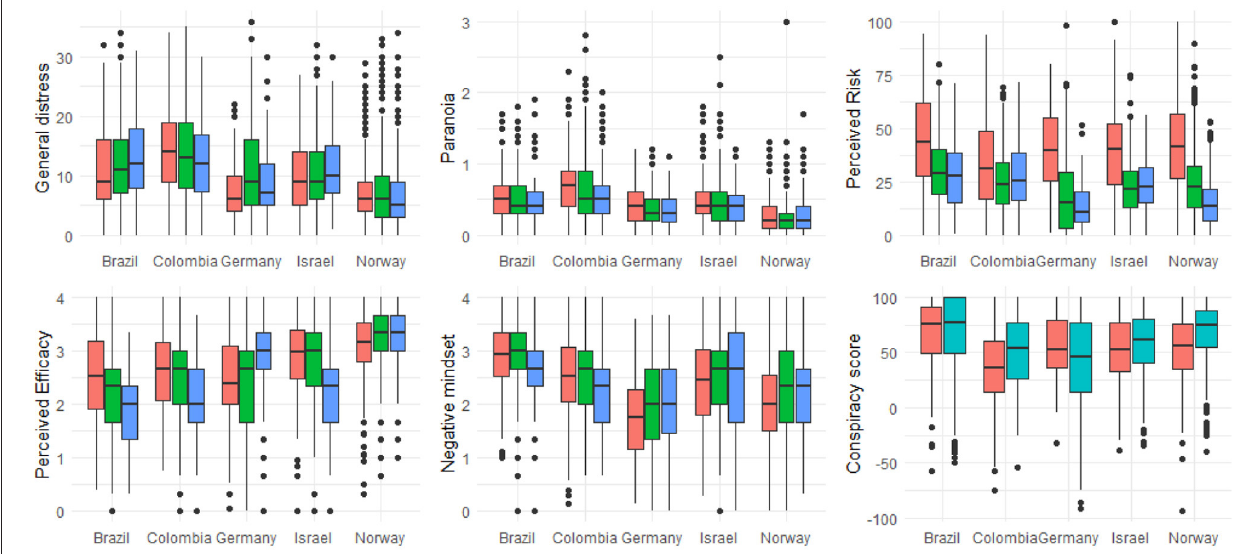
FIGURE 5 | Comparison to our March data. Paranoia and perceived risk declined from March to July. For more details, please see the Supplementary Material